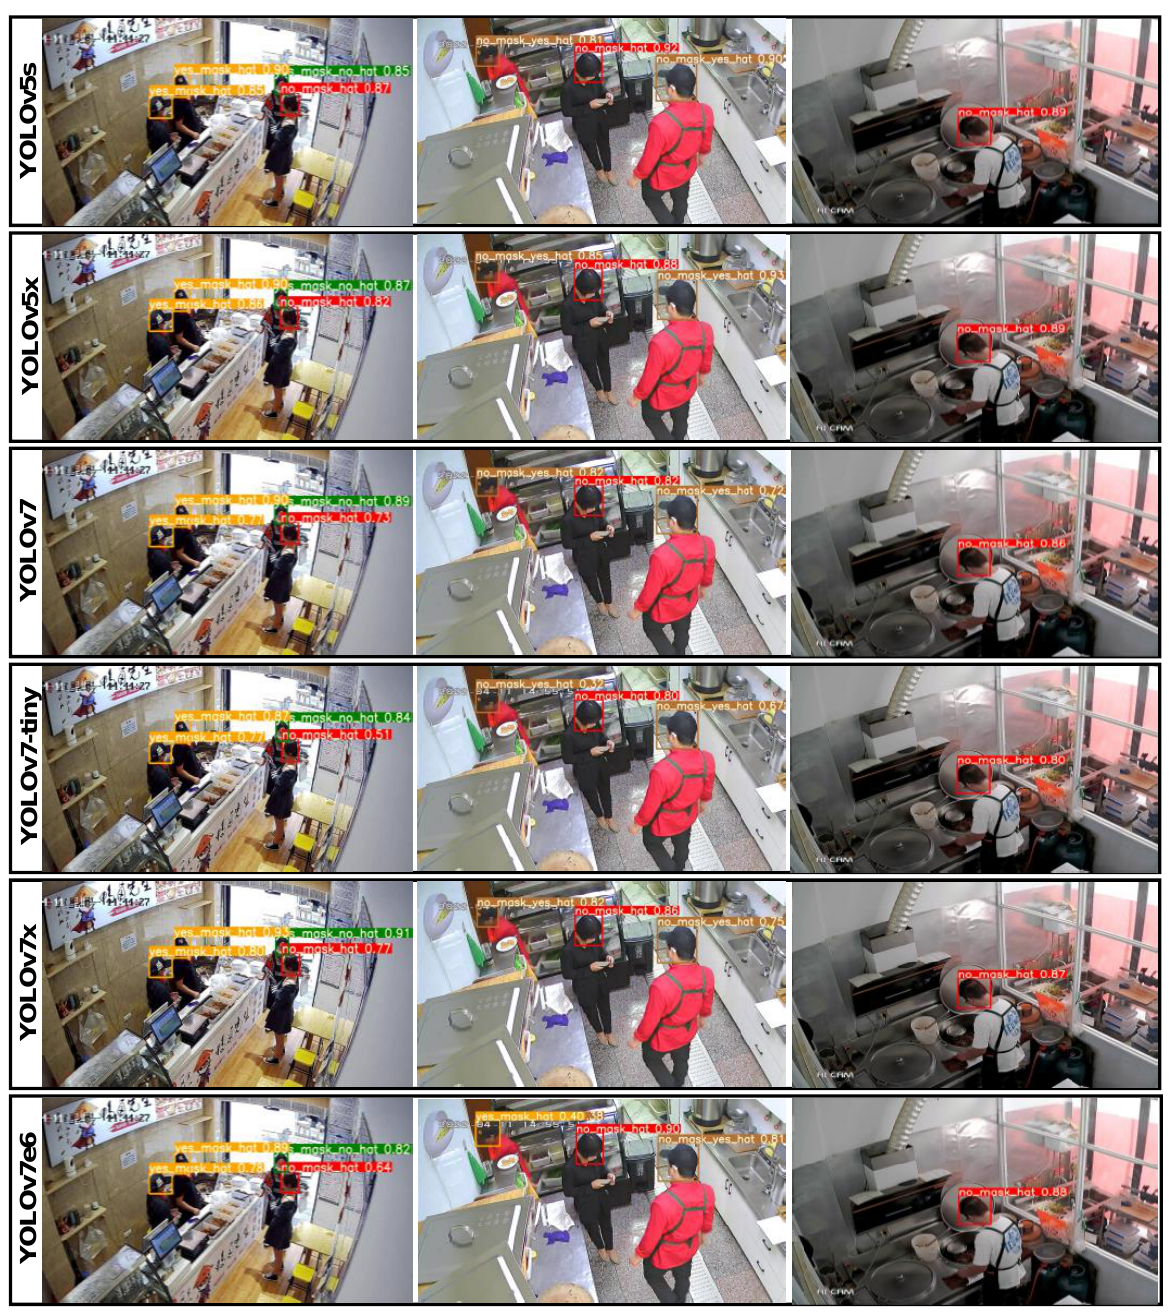
Figure 8. The detection performance of different models. It should be noted that the colors orange, green, red, and copper represent the labels yes_mask_hat, yes_mask_no_hat, no_mask_hat, and no_mask_yes_hat,